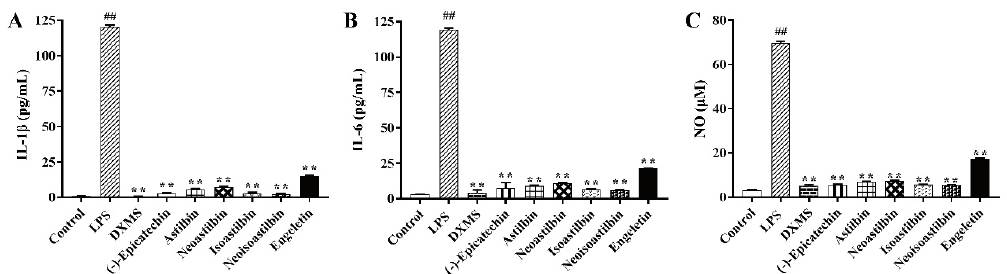
Figure 5. Effects of six flavonoids in Smilax glabra flavonoids extract (SGF) on the expression of inflammatory cytokines in RAW 264.7 cells. DXMS (dexamethasone) as positive control. RAW 264.7 cells were stimulated by lipopolysaccharide (LPS) (1 μ g/mL) for 6 hours, then treated with six flavonoids (100 μ M) or DXMS (5 μ M). The inflammatory cytokines levels of ( A ) IL-1 β , ( B ) IL-6 and ( C ) NO in cell supernatant were detected by ELISA. Data are expressed as means ± SD ( n = 3). ## p < 0.01, compared with control group; ** p < 0.01, compared with LPS group.